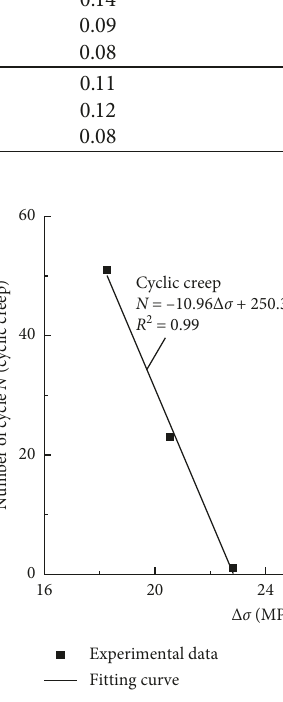
Figure 5: Cycle lifetime of rock salt under different loading